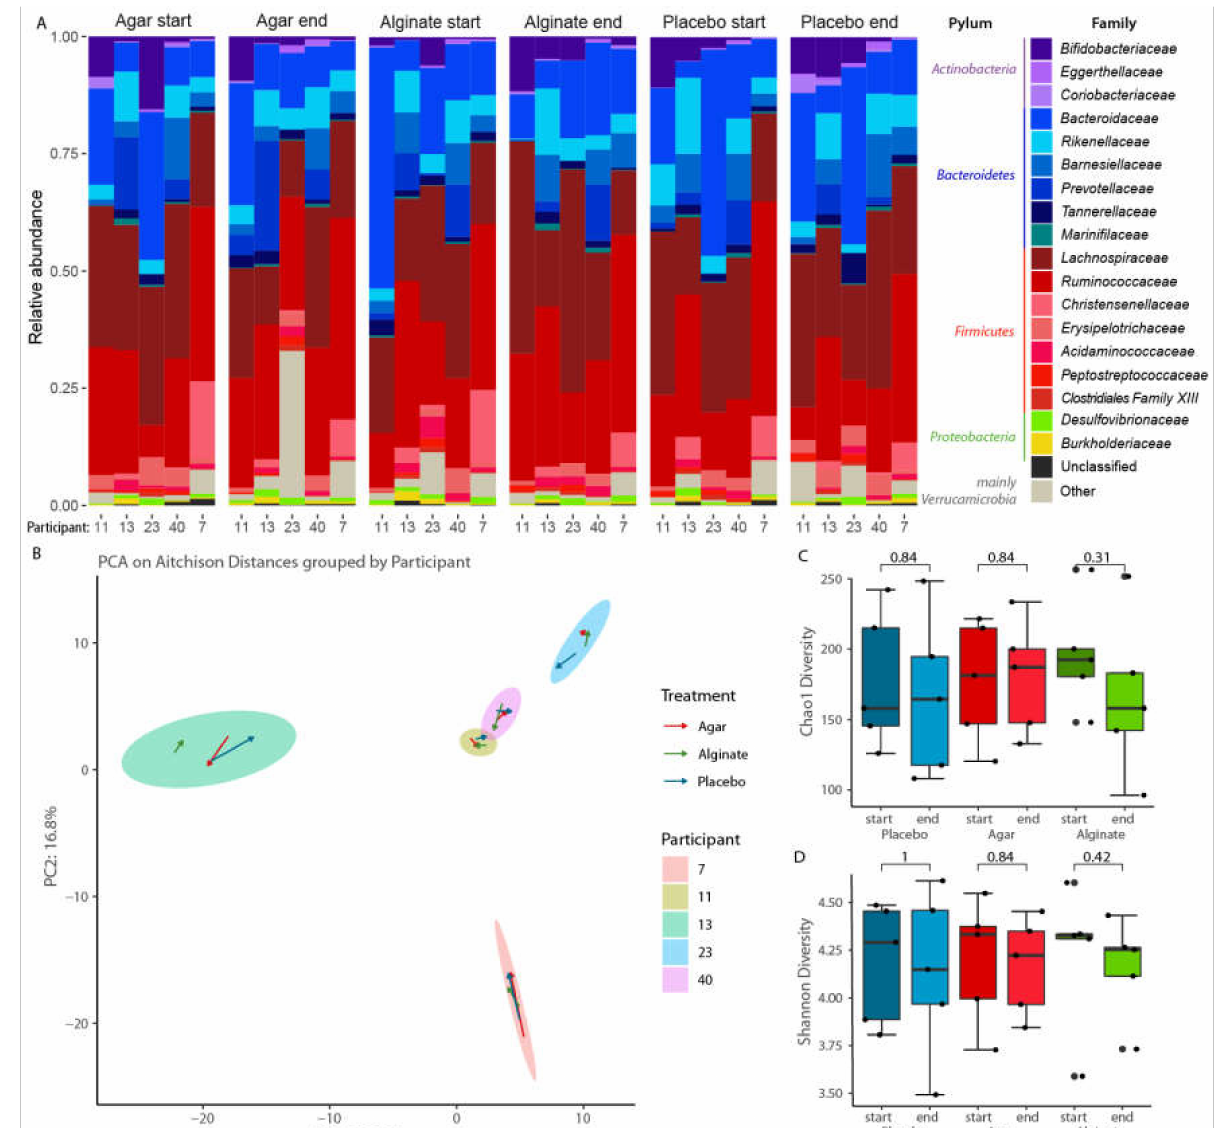
Figure 2. ( A ) Taxonomic composition at family level of each sample ordered vertically by phylum and horizontally by dietary intervention and participant. ( B ) Principal component analysis based on Aitchison distances on all ASVs present in at least two samples grouped by patient. The arrows indicate the shift of the microbial composition after each treatment. Comparison of ( C ) Chao1 diversity and ( D ) Shannon diversity before and after each dietary